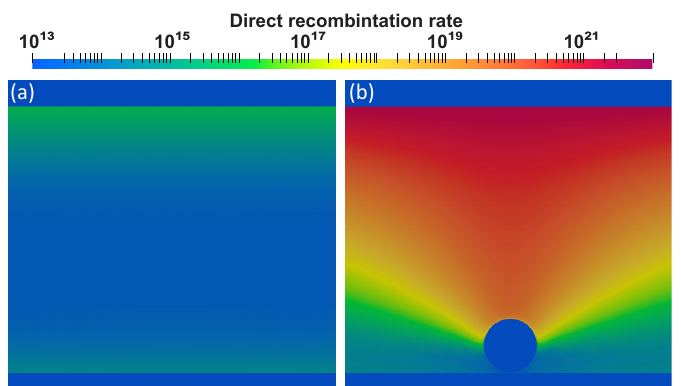
Figure 7. ( a ) Direct recombination in FAPbBr 2 I device at 1.5V without nanoparticles (NPs) and ( b ) with core-shell NP of the following geometry: 60 nm diameter of gold core and 10 nm thickness of SiO 2